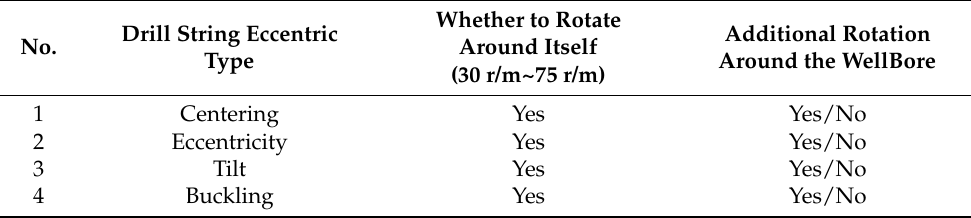
Figure 2. Profile of the drill collar and wellbore relative to each other. Table 2. Common movement characteristics and the eccentric displacement of the drill collar (IMWDDC) operation